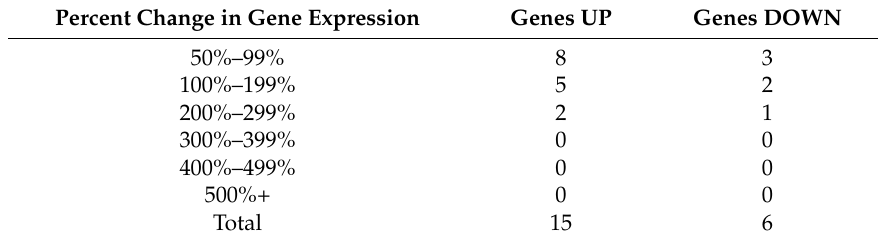
Table 17. Distribution of Gene Affected by GHK and Associated with Astrocytes.